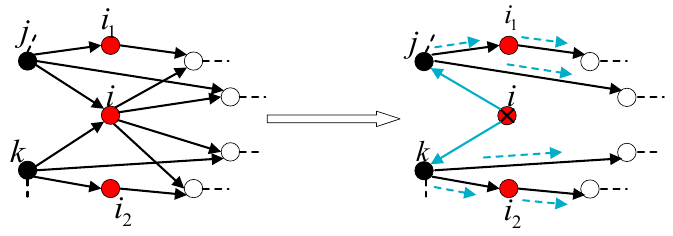
Figure 4. The first round of redistribution on the power side